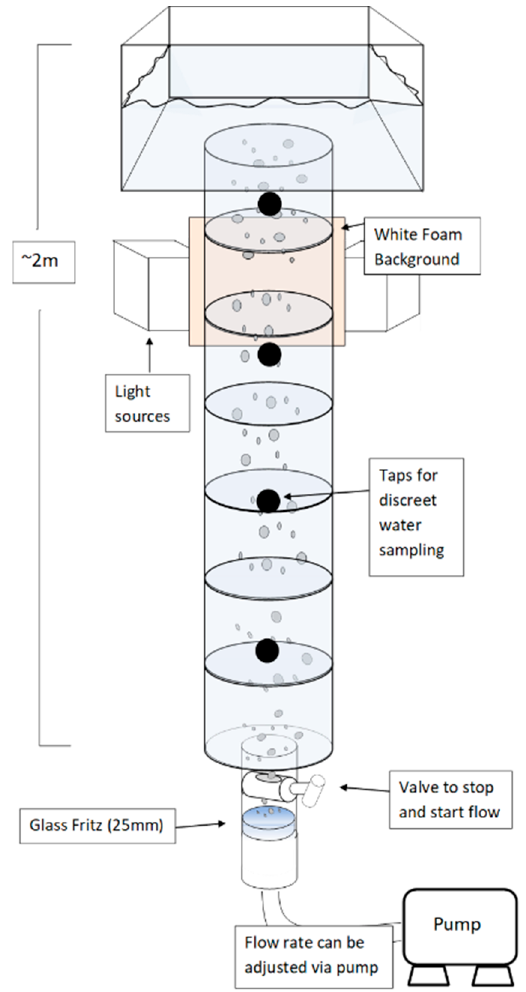
Figure 1. Schematic view of one tower (towers were built in triplicate) with detachable glass frits, adjustable air flow rate, discrete water sampling taps and surface microlayer (SML) sampling box.